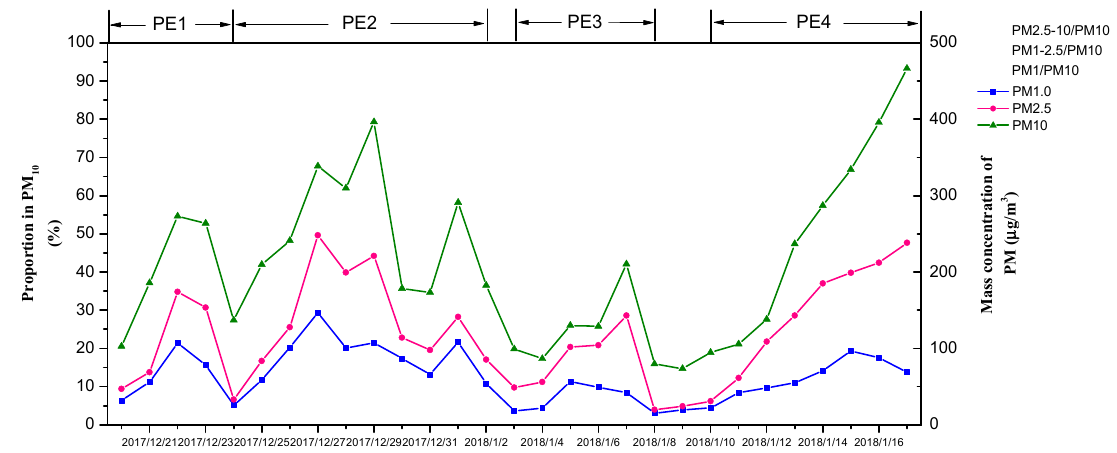
Figure 2. Concentration of particle mass in PM 1 , PM 2.5 and PM 10 .